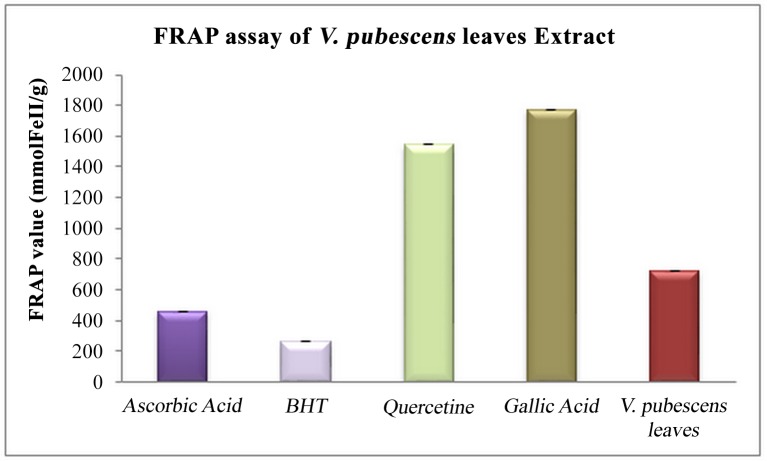
Total antioxidant activity.Total antioxidant activity of V. pubescens ethanolic extracts with synthetic reference standards (ascorbic acid, BHT, quercetin, and gallic acid) as determined by FRAP assay. The data are represented as the mean ± SEM.